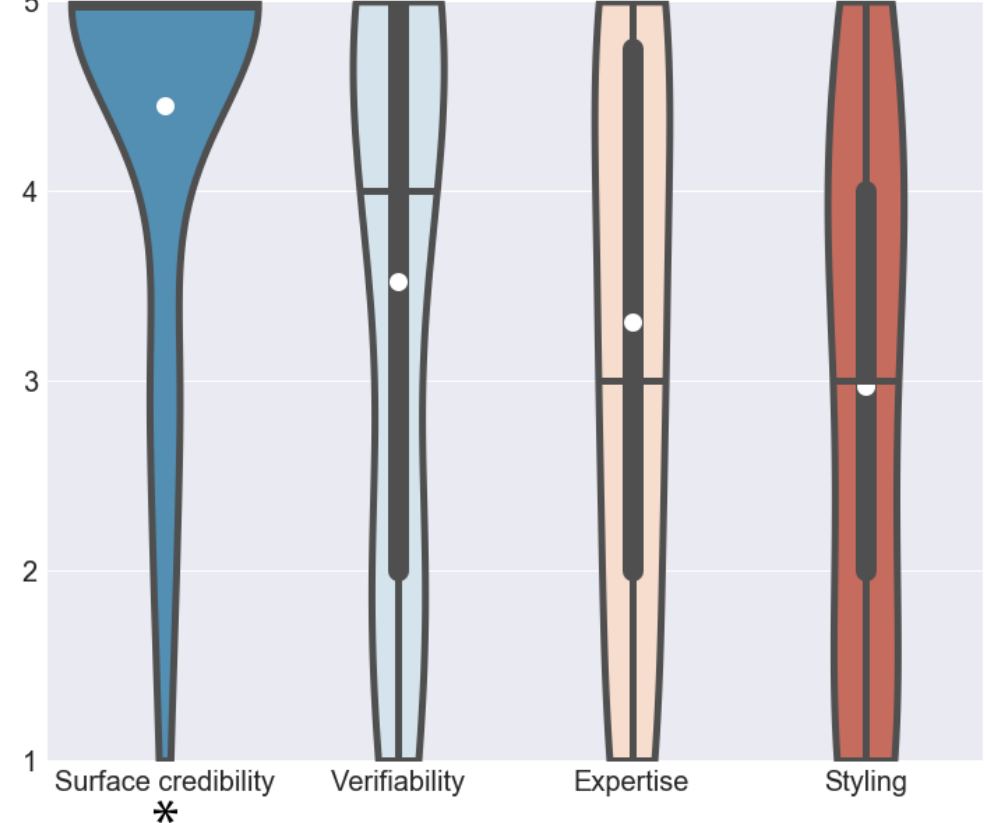
Figure 5. Scores of features in the group of Credibility & styling. The white dot denotes the mean value, the horizontal black bar denotes the